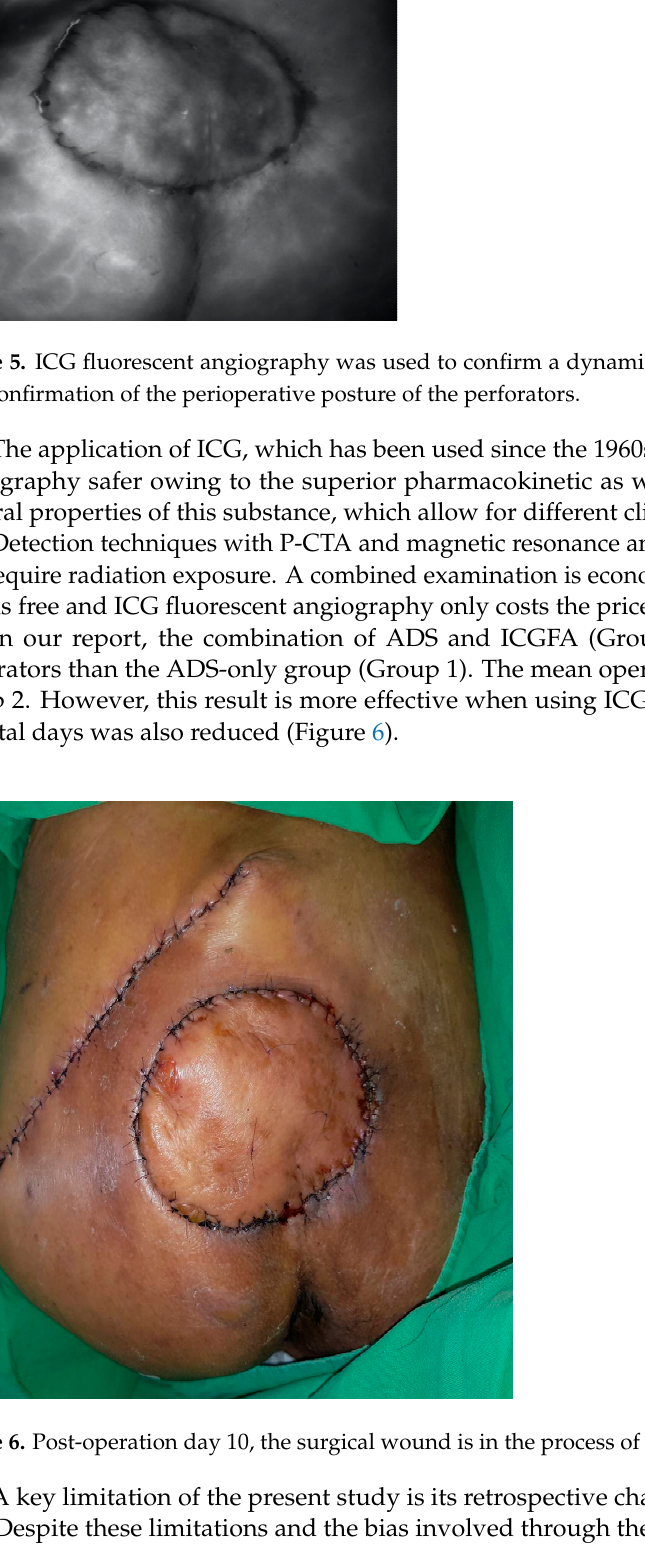
Figure 6. Post-operation day 10, the surgical wound is in the process of healing well.